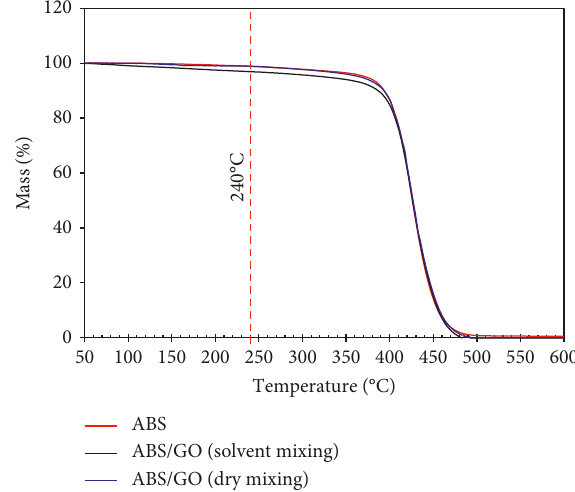
Figure 4: TGA thermogram of the ABS filament, ABS/GO (solvent mixing), and ABS/GO (dry mixing) composite